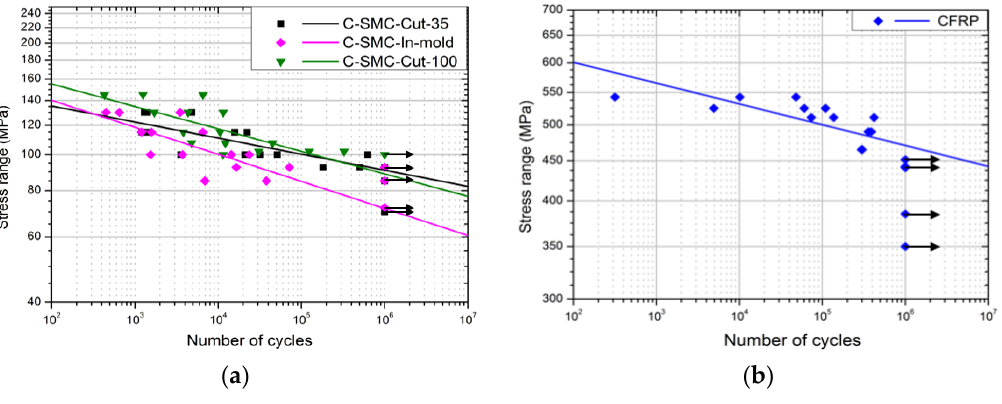
Figure 14. S-N curves of C-SMC and CFRP: ( a ) C-SMC, ( b ) CFRP.